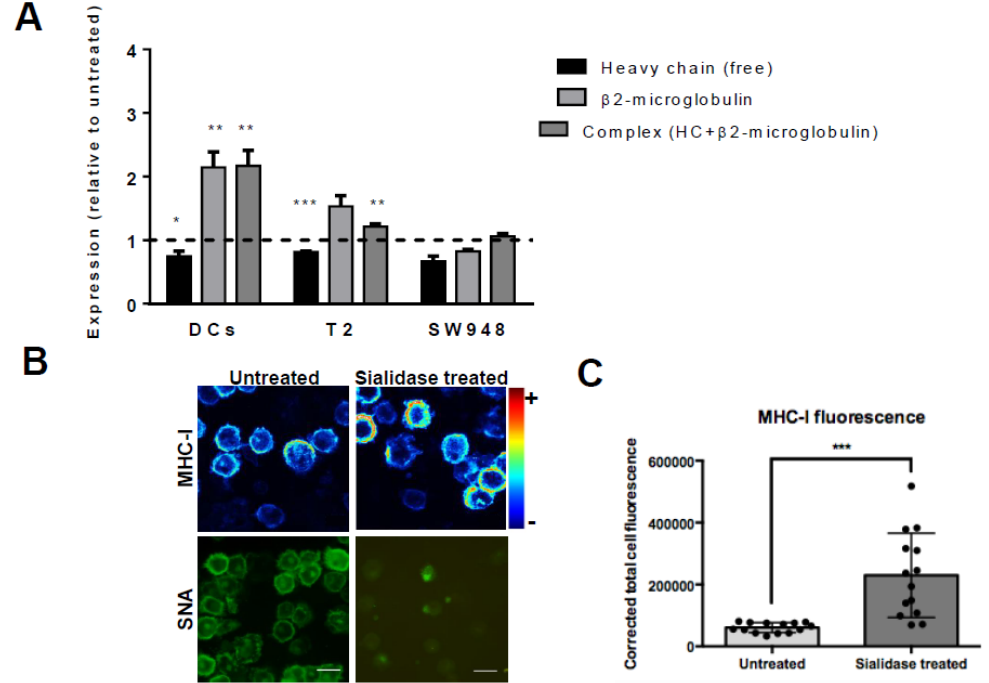
Figure 3. Desialylation increases MHC class I molecules in DCs and T2 cell line but not in the SW948 colon cancer cell line. ( A ) DCs, T2 cell line, and SW948 cell line were treated with sialidase for 1 h at 37 ◦ C and analyzed by flow cytometry for MHC-I staining (using the HC10 (free heavy chain); β 2m (BBM.1 antibody) and the complex heavy chain + β 2m (BB7.2 for T2 and W6 / 32 antibody for MoDCs and SW948) ( B ) Confocal microscopy pictures of immature human DCs probed for surface staining of MHC-I (W6 / 32 antibody). Human DCs were treated with sialidase and prepared on coverslips for confocal microscopy. A range of z-stack images was collected from different cells and processed to 389 include mean staining intensity. Scale bar equals 20 μ m. (C) The fluorescence of MHC-I by confocal 390 microscopy was quantified accordingly to the corrected total cell fluorescence (CTCF) method on at 391 least 14 different cells per slide, as described in the Methods section. Values presented are mean ± 392 SEM (N ≥ 5). Statistically significant differences are indicated by asterisks (* p ≤ 0.05, ** p ≤ 0.01, *** p ≤ 393 0.001). 394